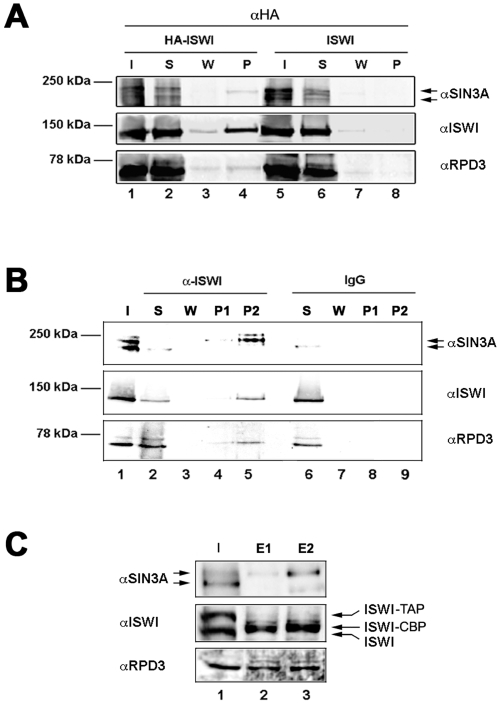
ISWI physically interacts with Sin3A and Rpd3 in embryo and larval stages.(A) Immunoprecipitation with anti-HA antibodies using embryo protein extracts derived from a line expressing HA-tagged ISWI (HA-ISWI) and from control extracts (ISWI). ISWI is specifically immunoprecipitated from the HA-ISWI extract together with the Rpd3 and Sin3A proteins. (B) Immunoprecipitation with the anti-ISWI antibody, but not with control IgG, immunoprecipitates Sin3A and Rpd3 on embryo protein extracts. Western blot analysis was performed on 10% of the total input extract [I], supernatant [S], wash [W], 5% of the total pellet [P1], and 30% of the total pellet [P] and [P2] using antibodies against ISWI, Sin3A and Rpd3. The arrows indicate two Sin3A isoforms detected by Western. (C) Larval nuclear extracts derived from larvae expressing TAP-tagged ISWI were bound to IgG Agarose beads. The ISWI-CBP fusion, consisting of the ISWI protein fused in frame with the calmodulin binding peptide, was eluted from the resin by cleavage with the TEV protease. The ISWI-CBP fusion protein eluted together with Sin3A and Rpd3 in nuclear extracts purified from larvae expressing TAP-tagged ISWI. The TEV cleaved eluate was rebound to a calmodulin coupled resin and the bound proteins were eluted by stripping the resin with SDS-loading buffer. Densitometric analysis indicate that ∼15% of total Sin3A and Rpd3 present in larval nuclear extracts associate with ISWI. Western blot analysis was performed on 0.05% of the total input extract [I], 3% of the TEV cleaved eluate [E1] and 3% of the SDS stripped eluate [E2], using antibodies against ISWI, Sin3A and Rpd3. Arrows indicate TAP-tagged ISWI [ISWI-TAP], ISWI fused in frame with the calmodulin binding peptide [ISWI-CBP] and endogenous untagged ISWI [ISWI].